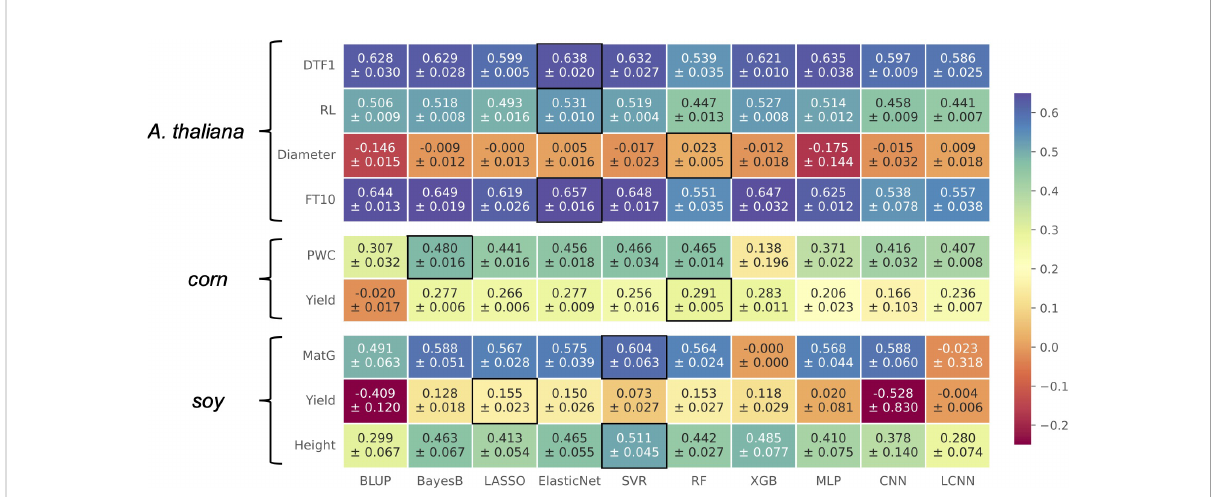
FIGURE 3 Results on real-world data for A. thaliana , soy, and corn shown in a heatmap: Each cell gives the explained variance v that the prediction model given on the horizontal axis achieved on the phenotype speci fi ed on the vertical axis. The color of each cell ranging from dark red to dark blue represents the prediction performance. The best result for each phenotype is highlighted by a black frame around the